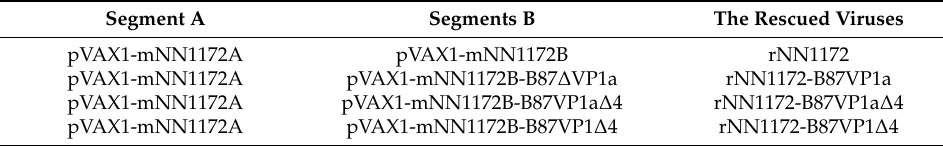
Table 2. Segments co-transfected with various combinations and the rescued viruses. Segment A Segments B The Rescued